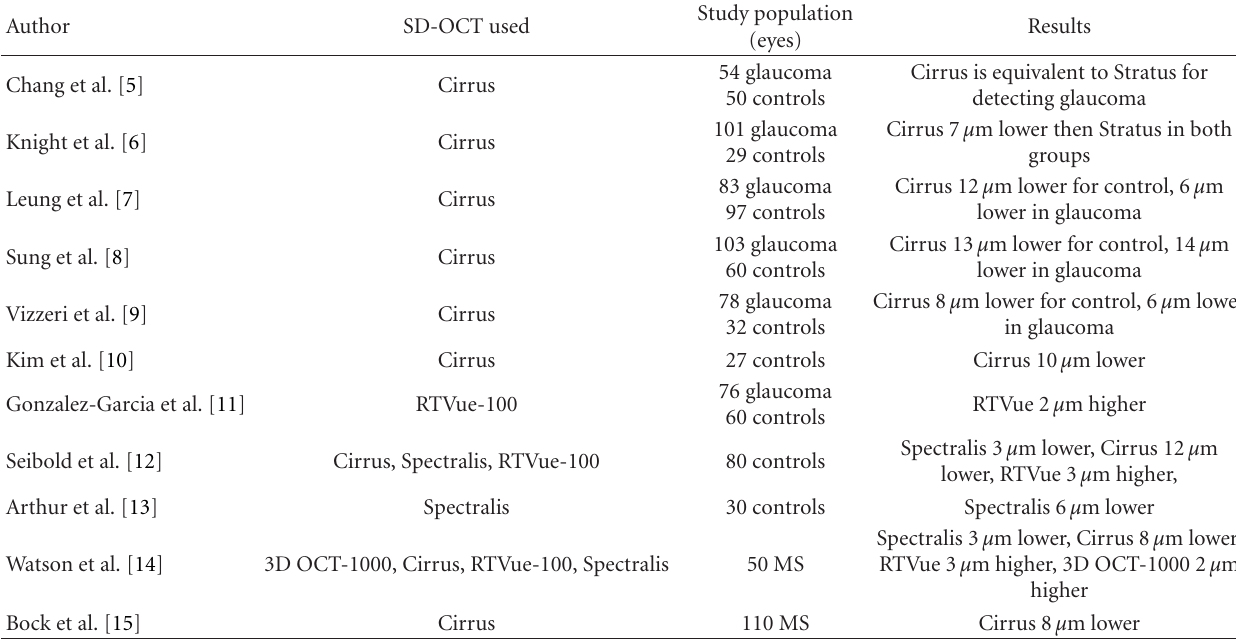
Table 4: Overview published studies comparing RNFLT in SD-OCT versus